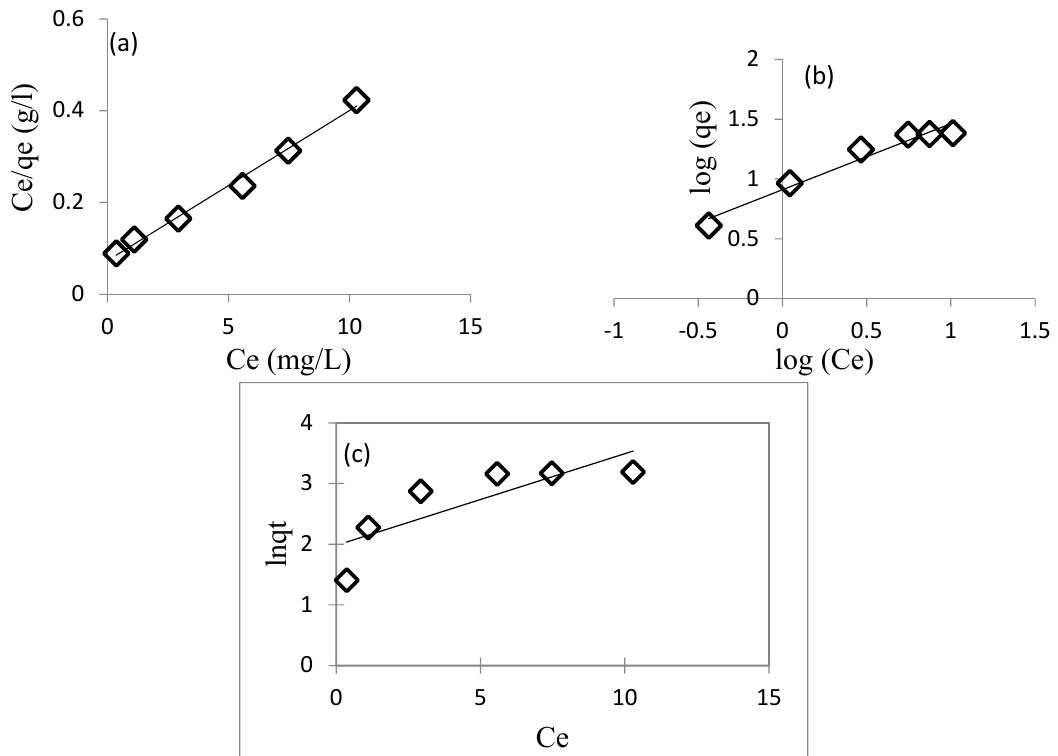
Figure 9. Isotherms models for adsorption of Cu 2+ on IIP/Mt at room temperature: Langmuir ( a ), Freundlich ( b ), and Jovanovic ( c ).